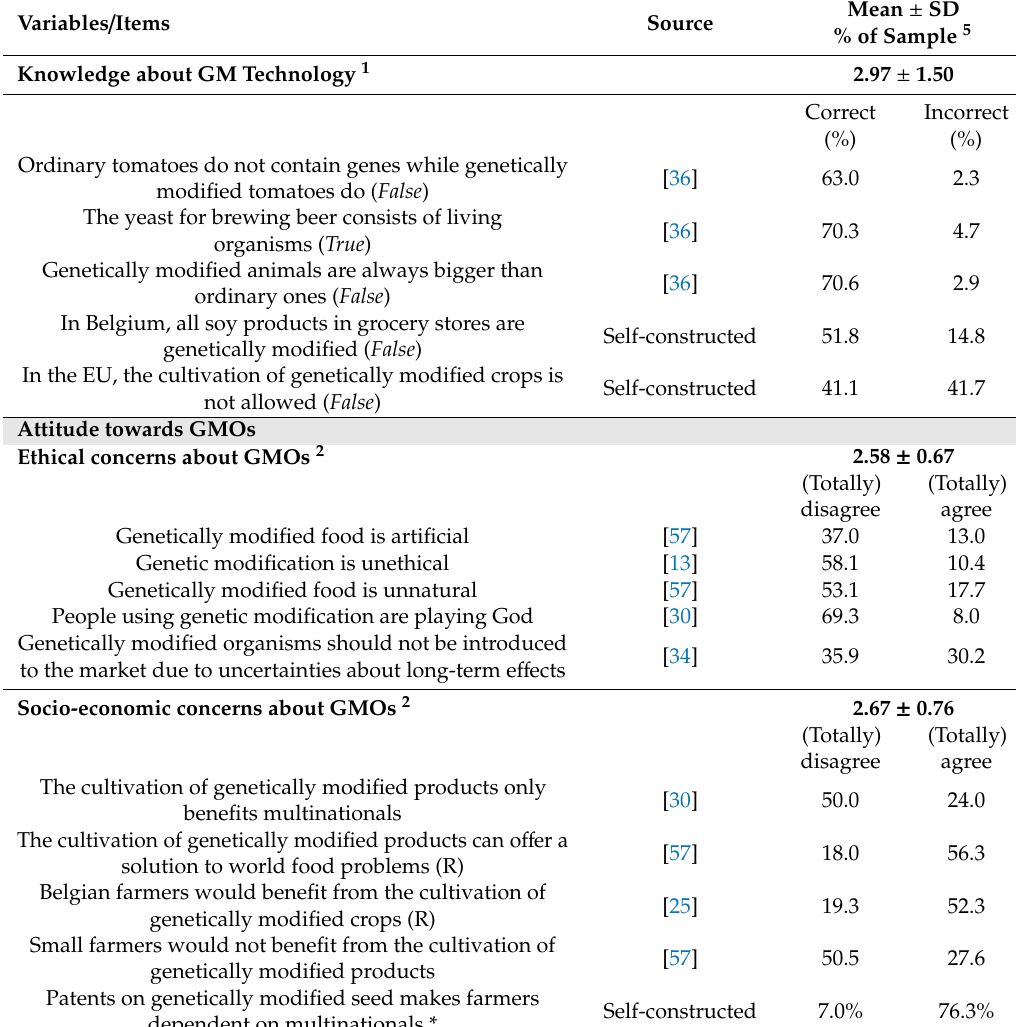
Table 3. Knowledge of GM (genetically modified) technology and attitudinal variables related